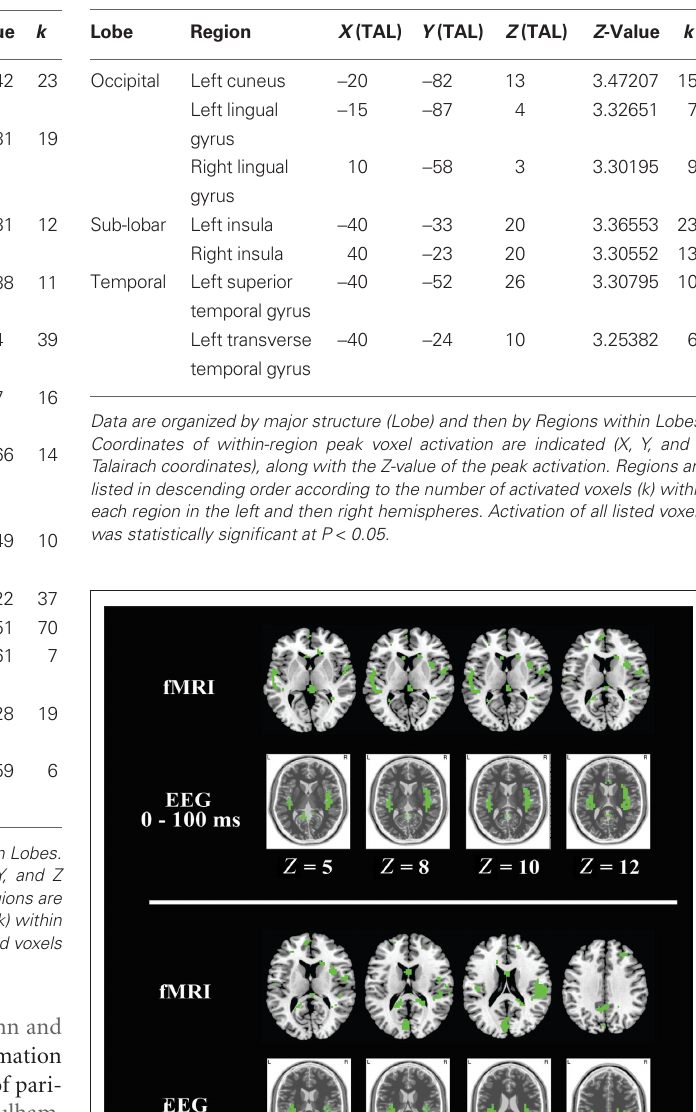
Table 3 | Electroencephalography activation differences specific to [incorrect > tool] > [correct > tool] from 0 to 100 ms following image onset.